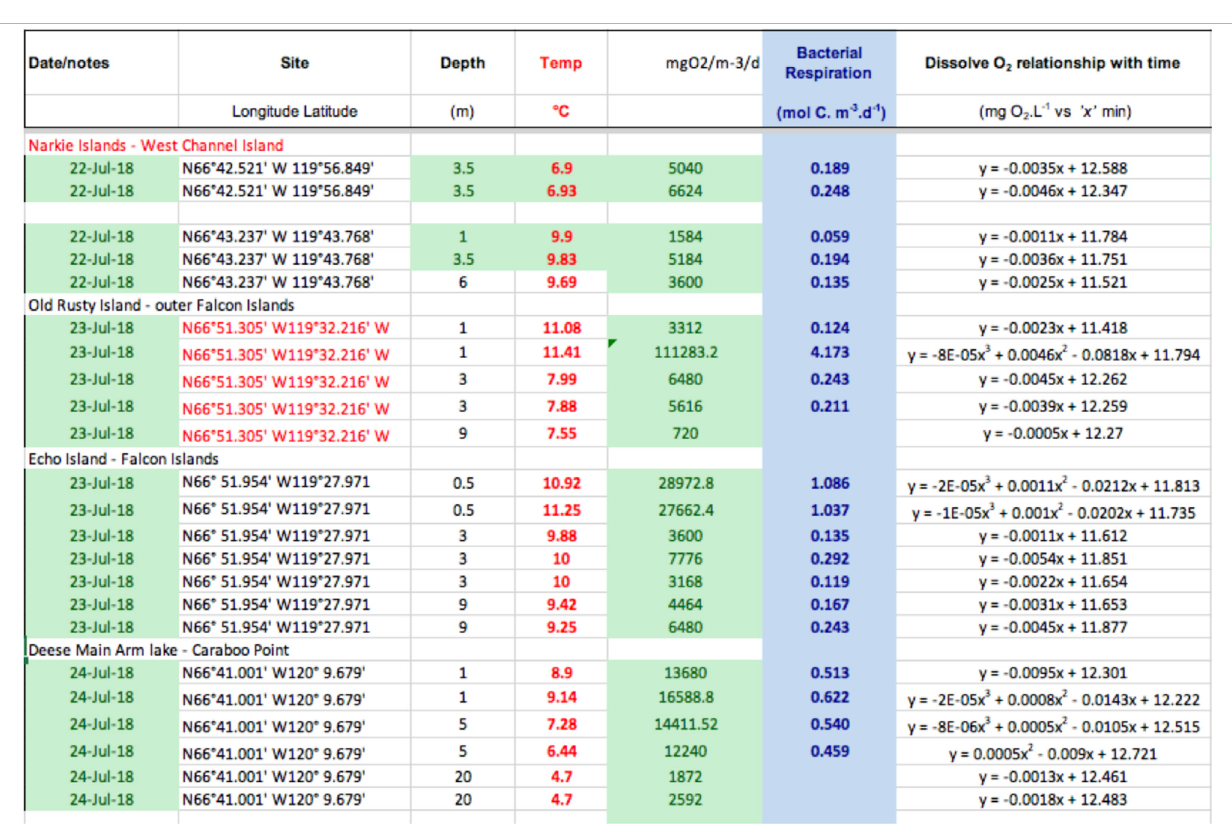
TABLE 2 | A few Great Bear Lake water sample calculations of bacterial